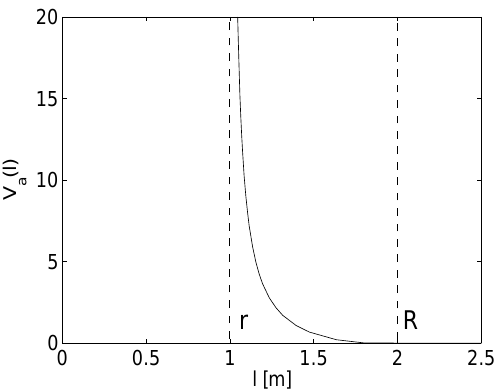
Figure 1. Artificial potential functions (APF) as a function of distance to the centre of the robot (indexes omitted for